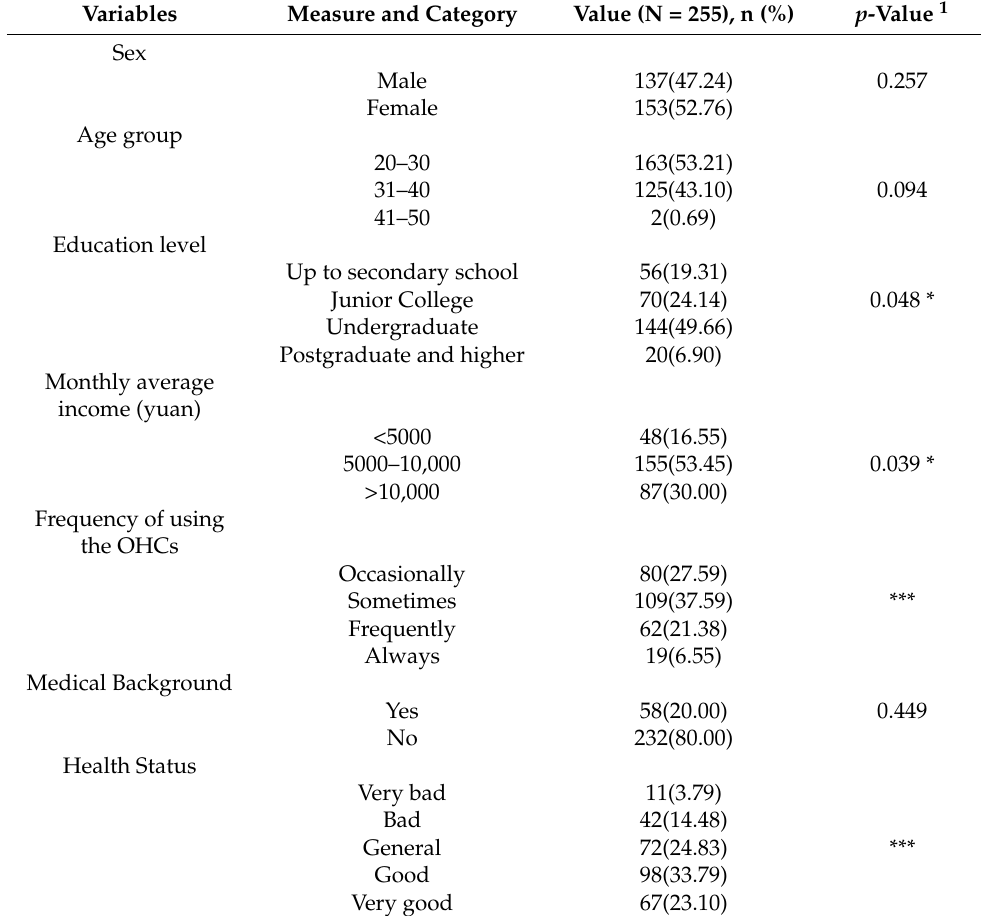
Table 2. Demographic characteristics of the participants (N =